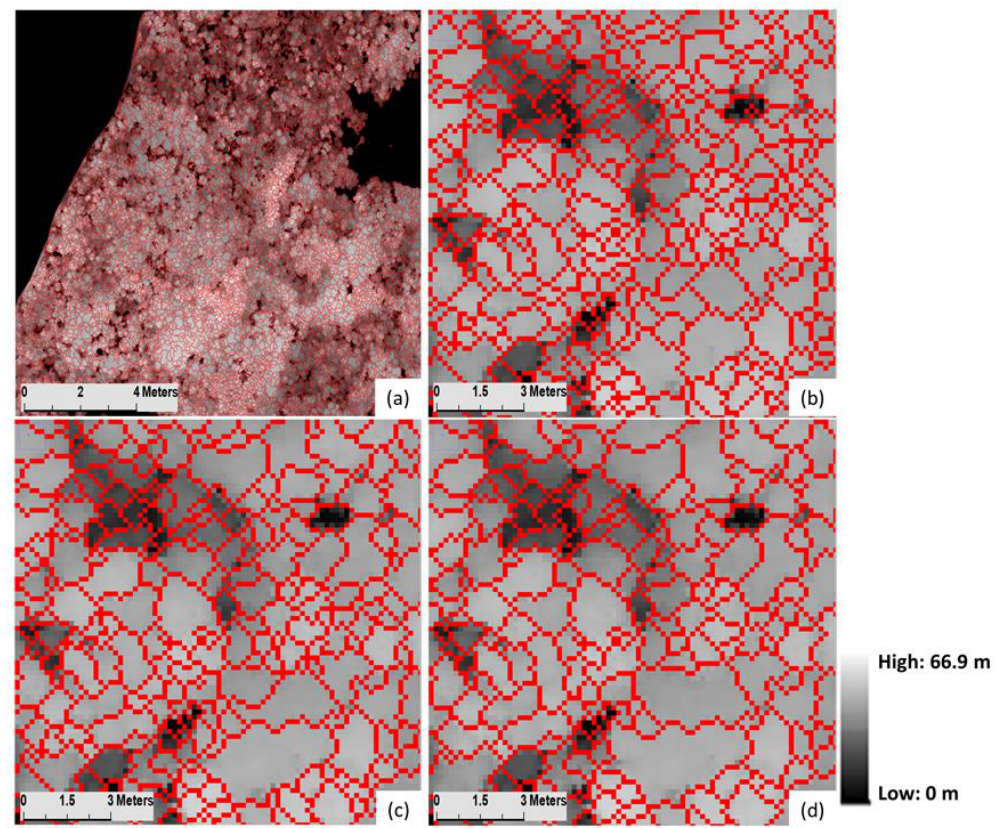
Figure 7. The crown segmentation map of the FRIM site: ( a ) crown segmentation map over 100 ha and the segmentation at ( b ) small, ( c ) medium and ( d ) large tree crown levels with the corresponding filtered images in the background.